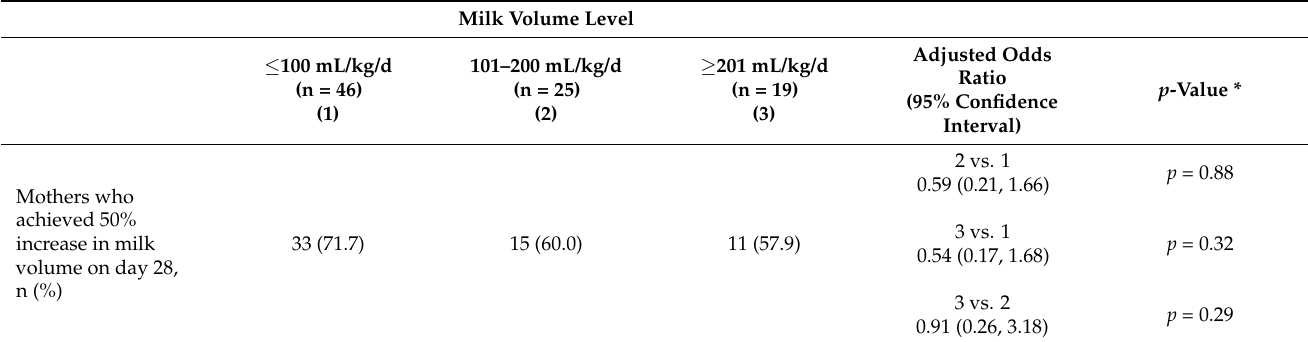
Table 4. Secondary outcome: number of women achieving 50% increase in milk volume by day